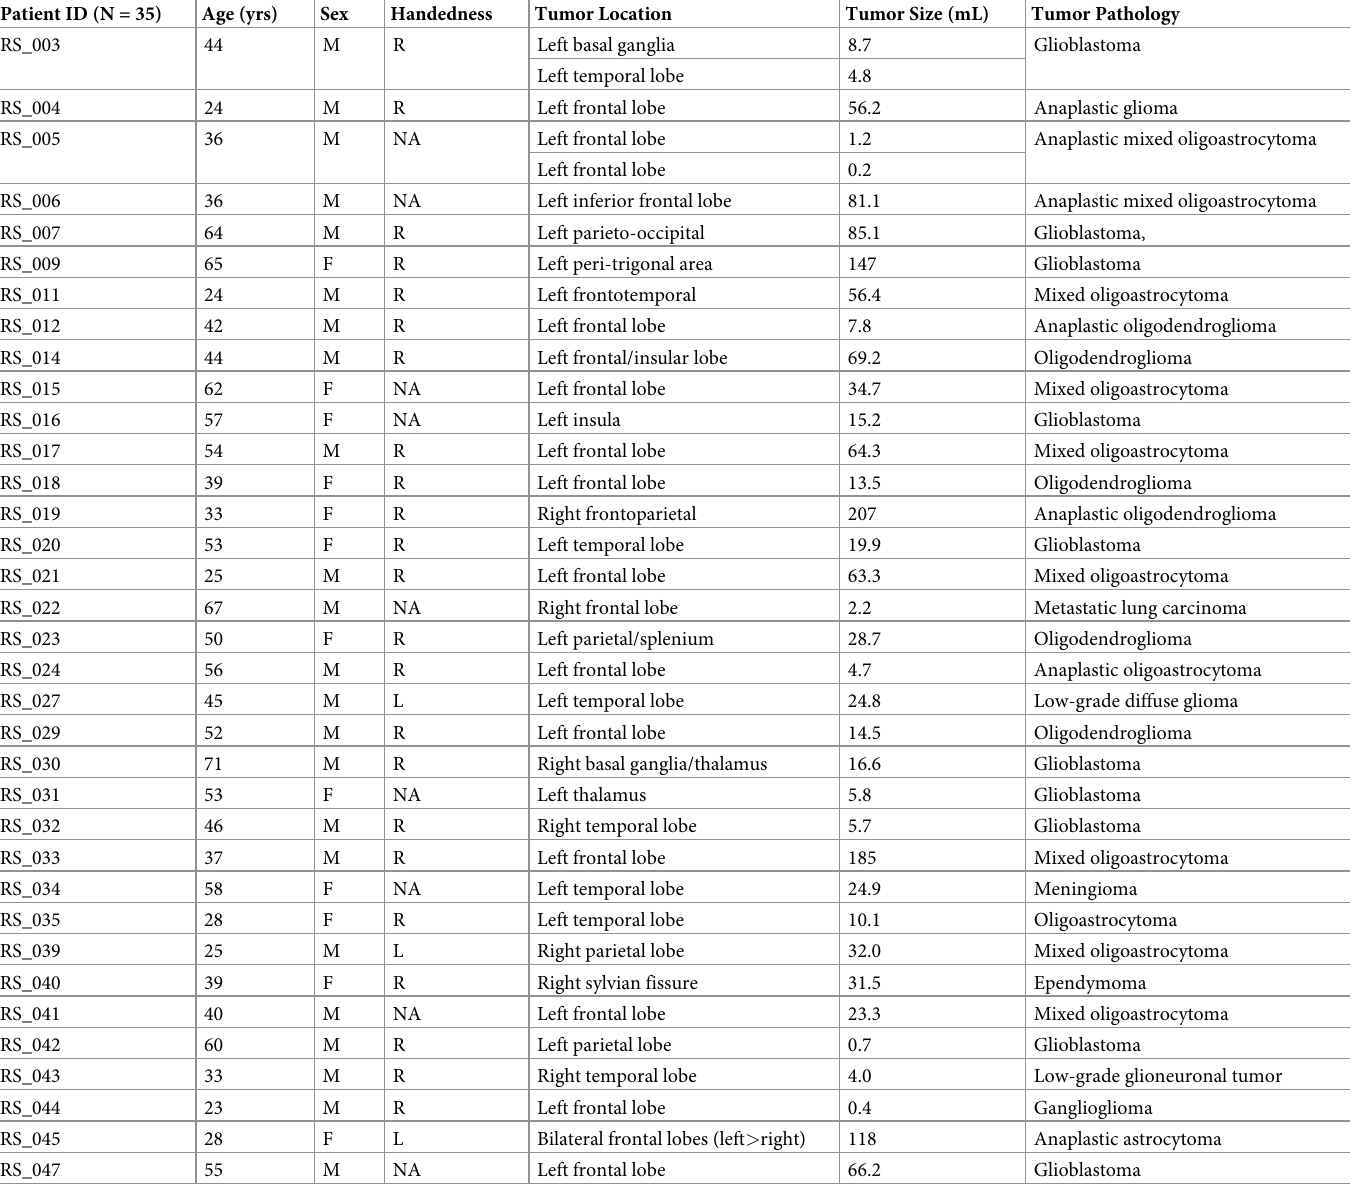
Table 1. Patient clinical and demographic